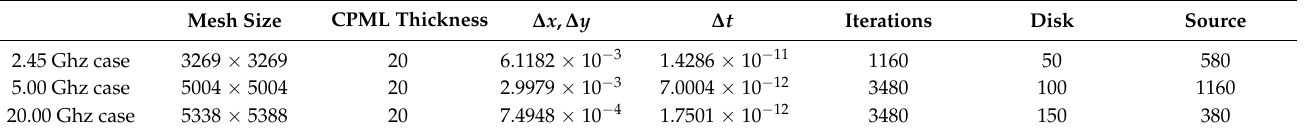
Table 3. Experiments setup for the free space scenery. Iterations refer to the number of time steps performed. Disk, to the number of iterations when the information has to be transferred to the CPU and saved to the disk. Source, refers to the number of operations when the source is turned off. Mesh Size ∆ t